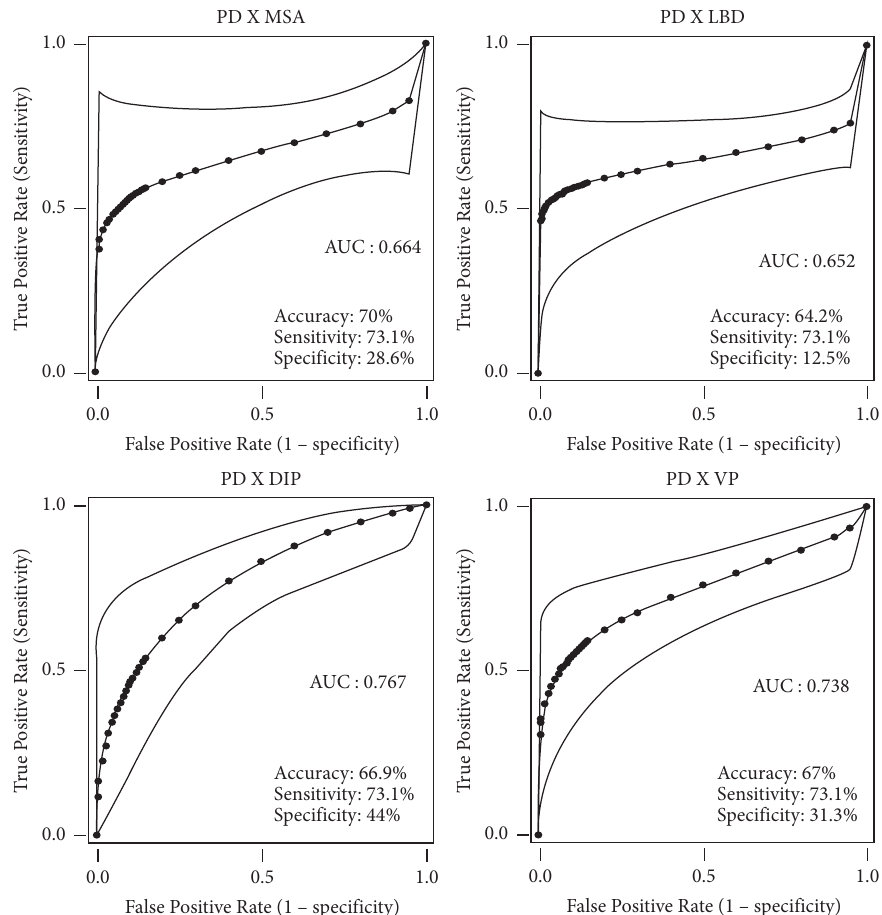
Figure 2: Comparison of SPECT-TRODATresults among patients with Parkinson’s disease and other Parkinsonisms ∗ . ∗ Normal results and those that did not correspond to the clinical picture (symmetry) were considered negative. For the calculations, unilateral and bilateral results were considered different. PD � Parkinson’s disease, MSA � multisystem atrophy, LBD � Lewy body dementia, DIP � drug-induced Parkinsonism, VP � vascular